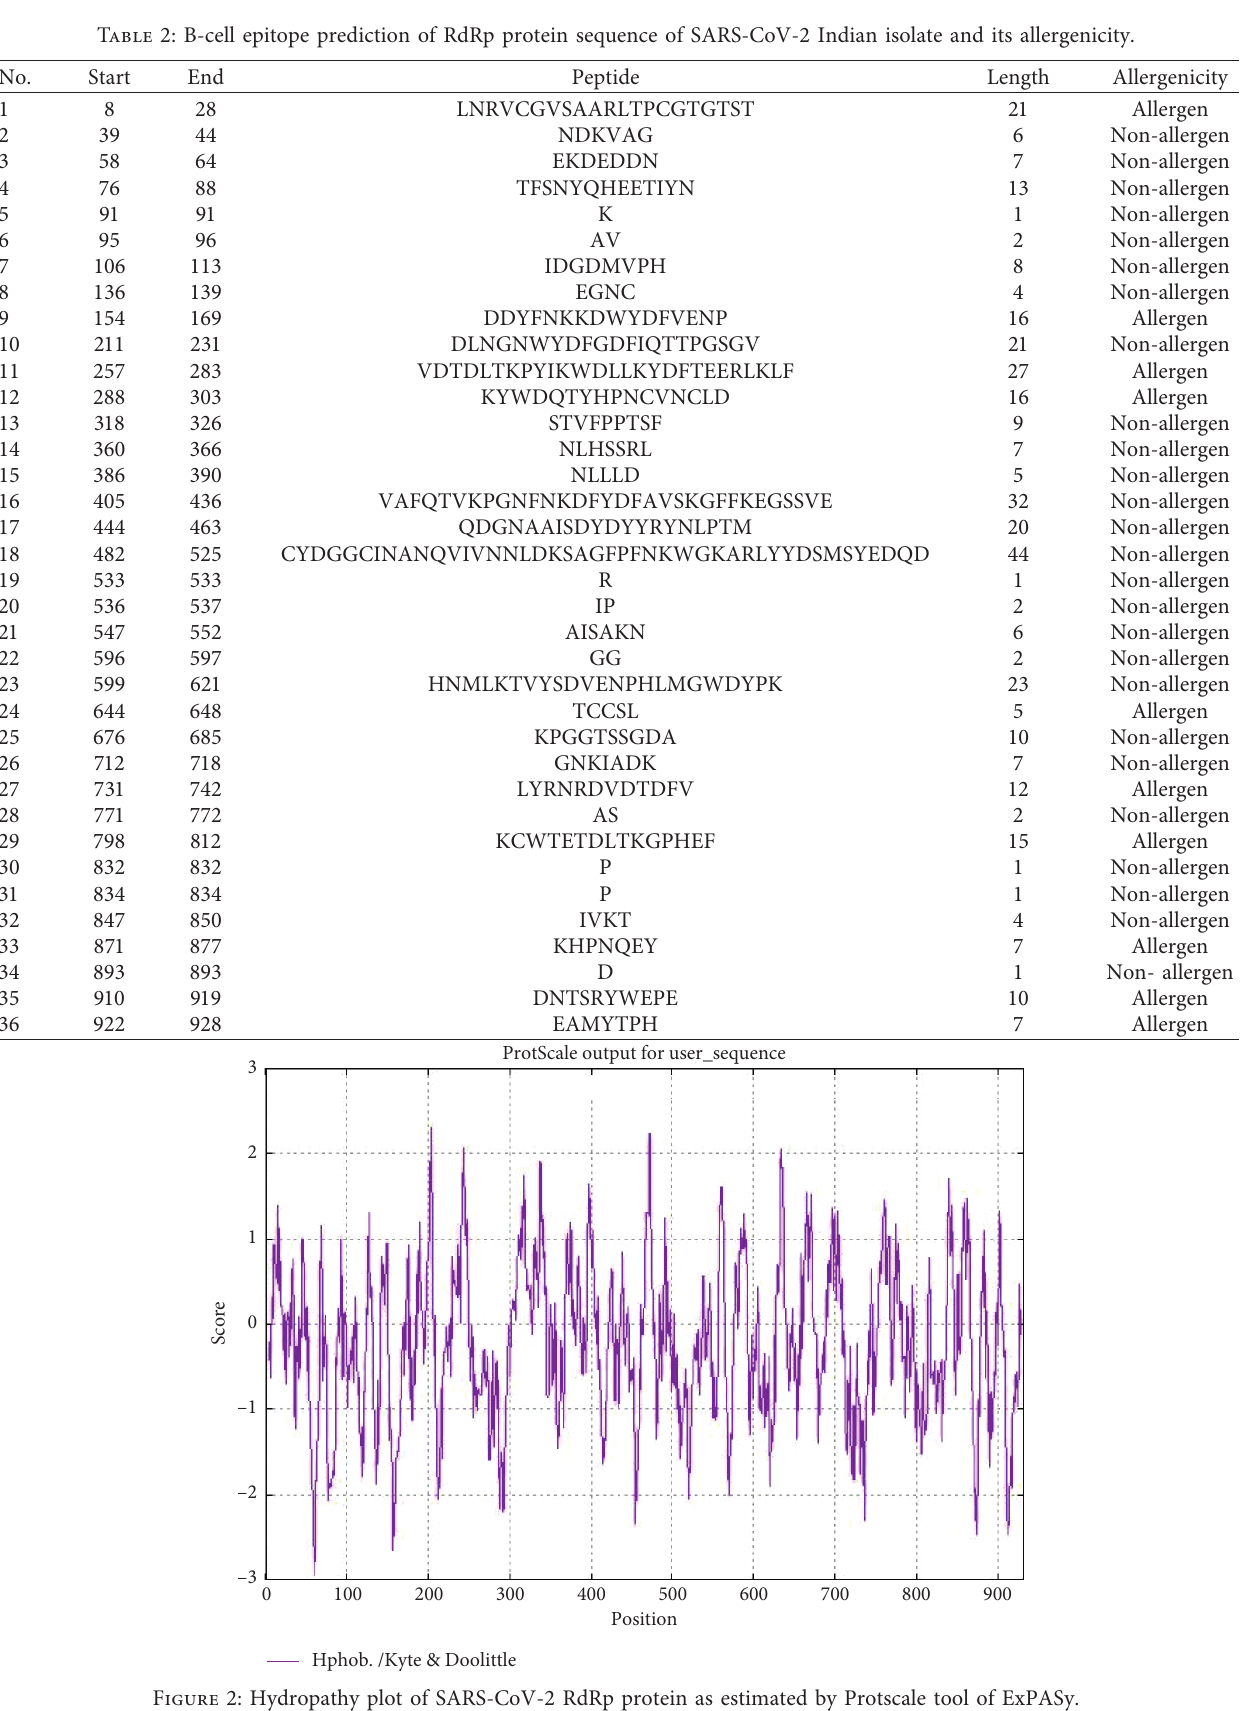
Figure 2: Hydropathy plot of SARS-CoV-2 RdRp protein as estimated by Protscale tool of